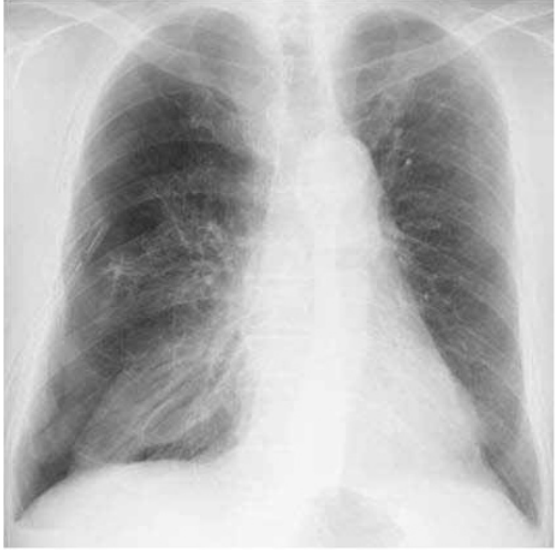
Figure 2. Chest radiograph soon after 20 Fr large bore chest tube replacement.